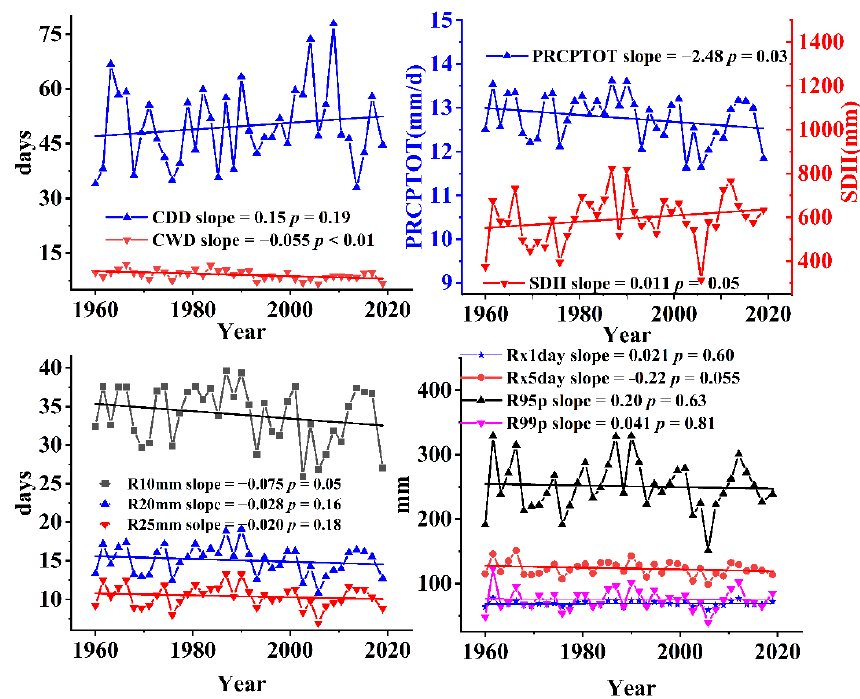
Figure 4. Changes in annual extreme precipitation indices in Yunnan during 1960 − 2019. Notes: The annual values of these extreme temperature indices are calculated by averaging 120 meteorological stations for the same year.